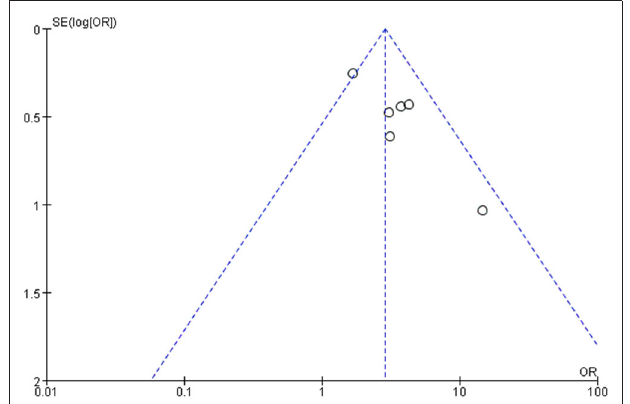
FIGURE 2 | Funnel plot of the